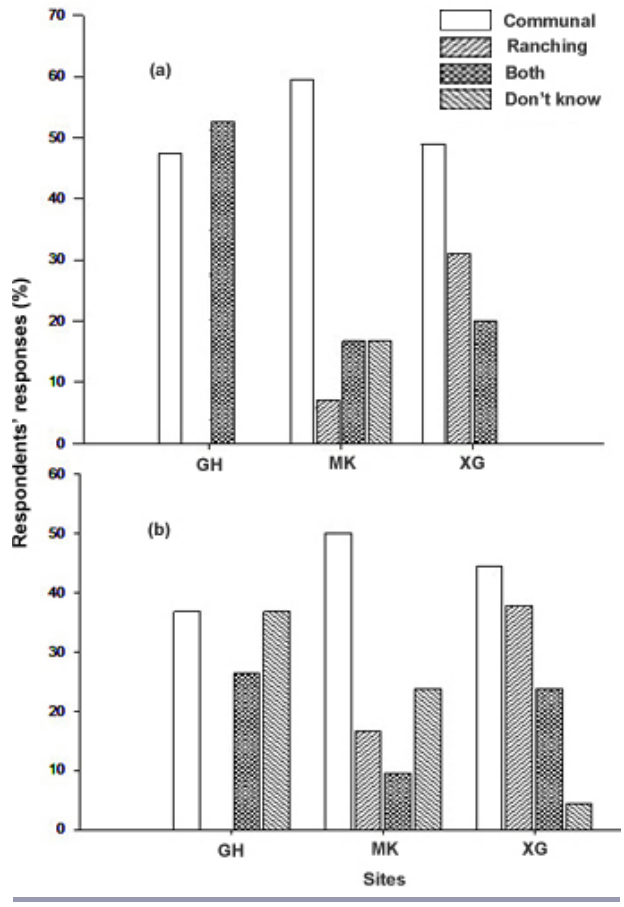
Fig. 2 . Grass composition change (a) and bush encroachment (b) in relation to grazing management systems as percieved by pastoralists at Goodhope (GH), Matlolakgang (MK), and Xanagas (XG) (Missing columns = no